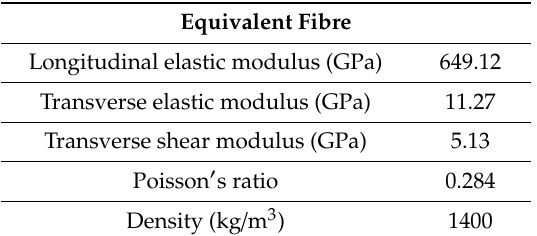
Table 1. Properties of the equivalent fibre for SWCNT (10,10) [10].